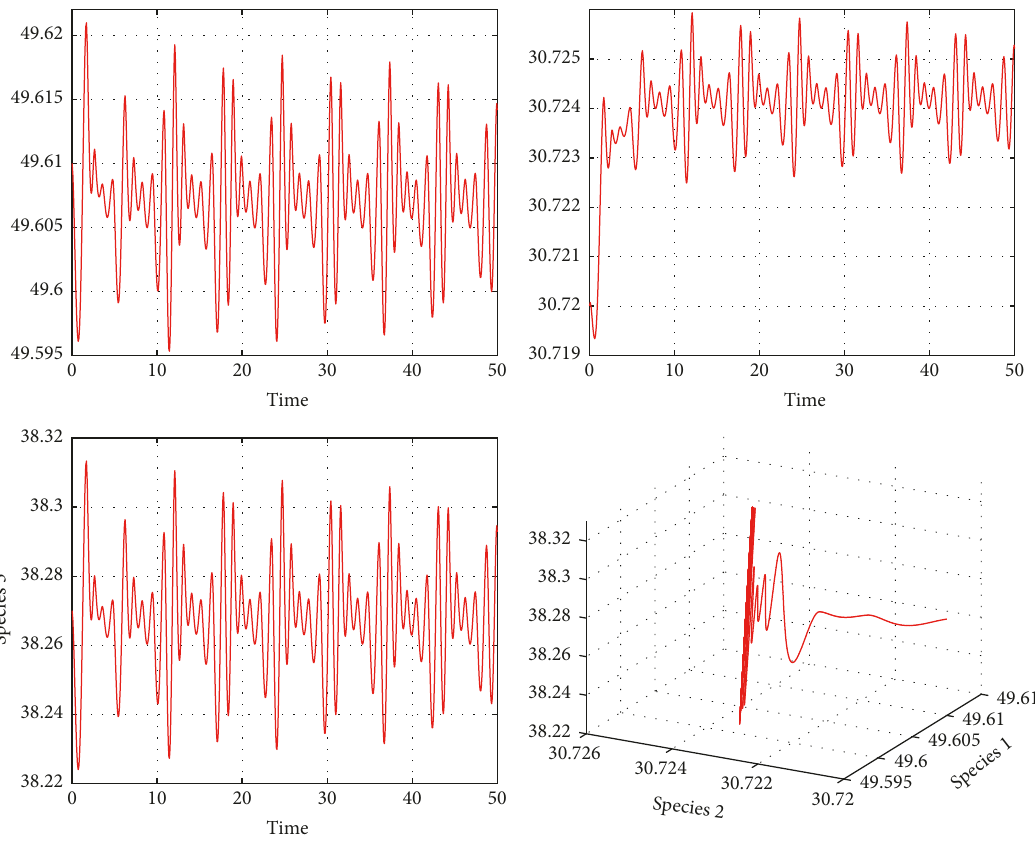
Figure 8: Dynamical behaviors and phase space trajectories of the three marine